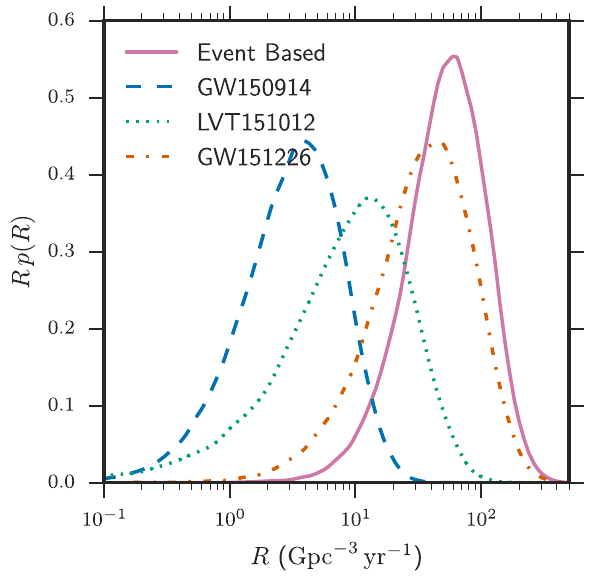
FIG. 10. The posterior density on the rate of GW150914-like BBH, LVT151012-like BBH, and GW151226-like BBH merg- ers. The event-based rate is the sum of these. The median and 90% credible levels are given in Table II. results for these population assumptions are also shown in Table II and in Fig. 10. The inferred overall rate is shown in Fig. 11. As expected, the population-based rate estimates bracket the one obtained by using the masses of the observed black hole binaries.